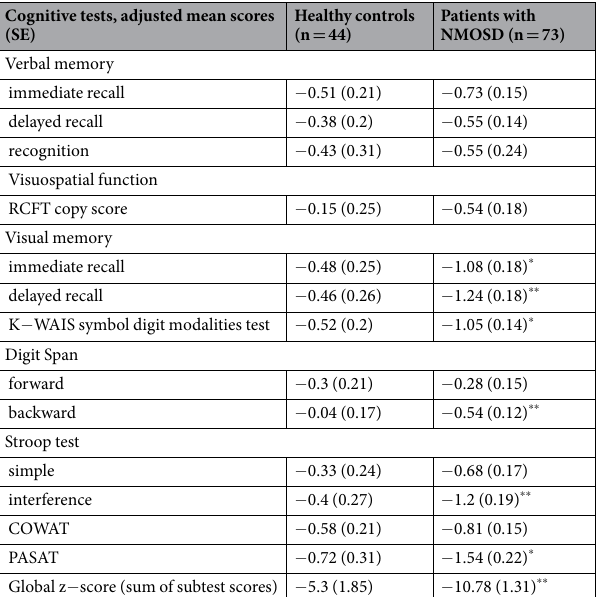
Table 2. Comparison of cognitive scores of healthy controls and patients with NMOSD. Abbreviations: BFI = Brief Fatigue Inventory; EDSS = Expanded Disability Status Scale; HCs = healthy controls; NA = not applicable; NMOSD = neuromyelitis optica spectrum disorder; PHQ-9 = Patient Health Questionnaire-9; SD = standard deviation; SE = standard error. All comparisons of cognitive function were corrected for age, educational level, and depression level. * p < 0.05 compared to healthy controls. ** p < 0.01 compared to healthy